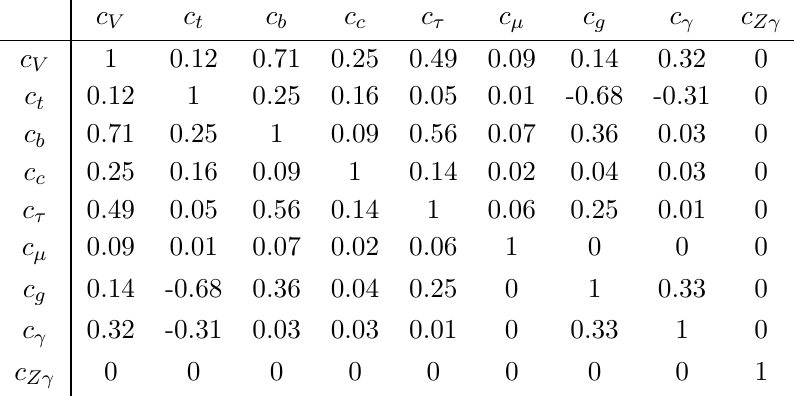
Table 3 . Correlation matrix for the (cid:12)t around the SM solution using the set of priors denoted as P EFT and the full data set of Higgs observables from Tevatron and the LHC runs 1 and 2 ((cid:12)rst column in table